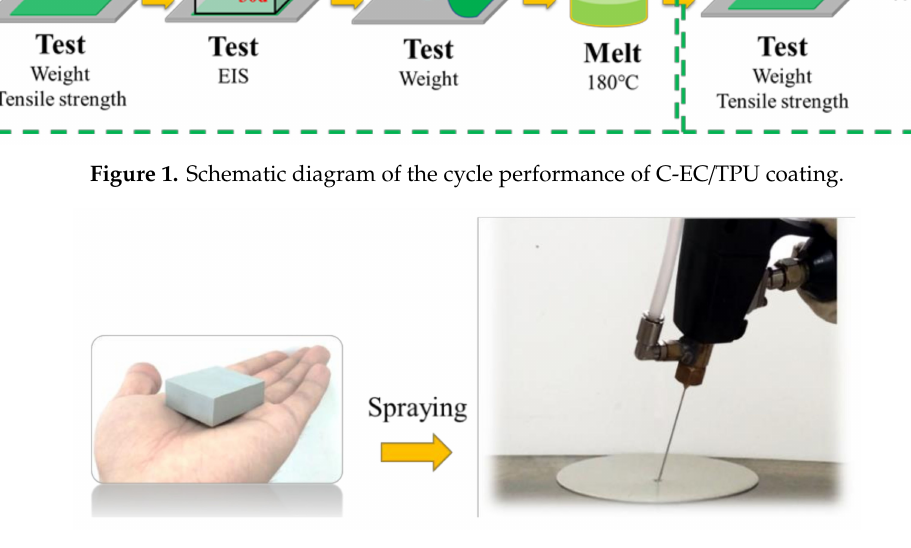
Figure 2. The hot melt-spraying of C-EC / TPU coating at 180 ◦